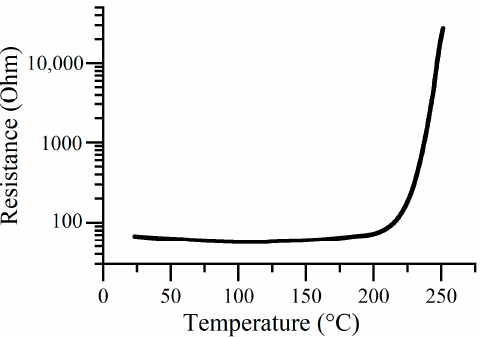
Figure 3. The temperature dependence of the electrical resistance of IDE with doped polyNiMeOSalen.